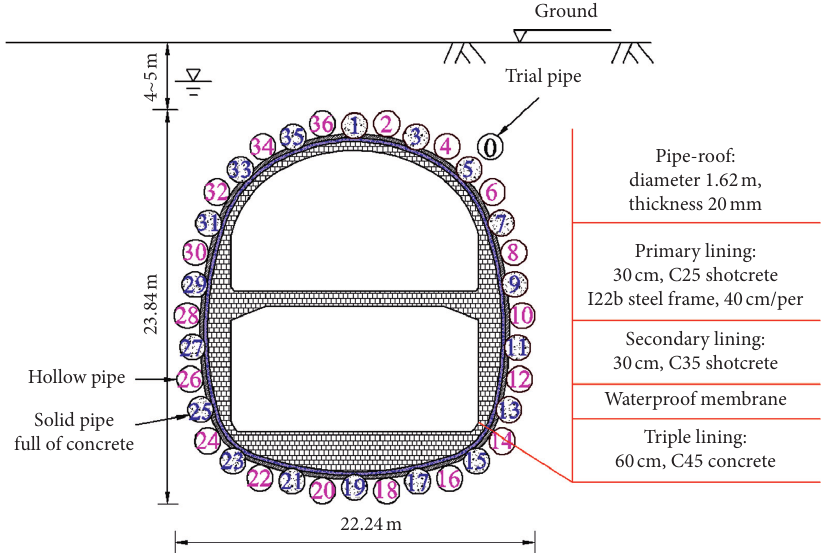
Figure 2: Schematic diagram of the Gongbei tunnel section and the supporting